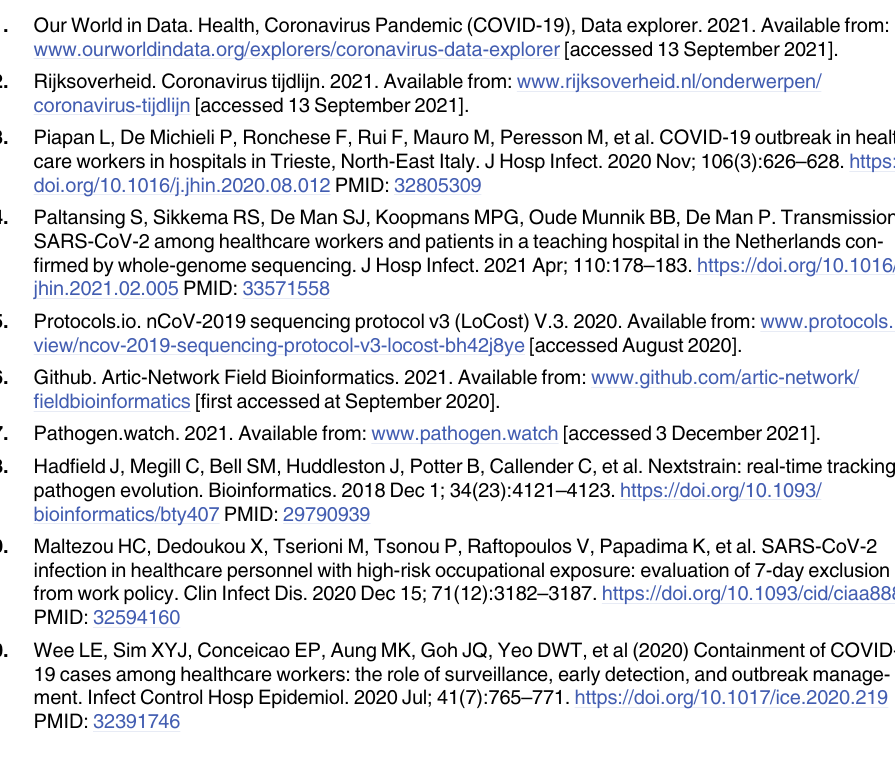
S1 Table. Diagnostic and demographic characteristics of three intra-hospital